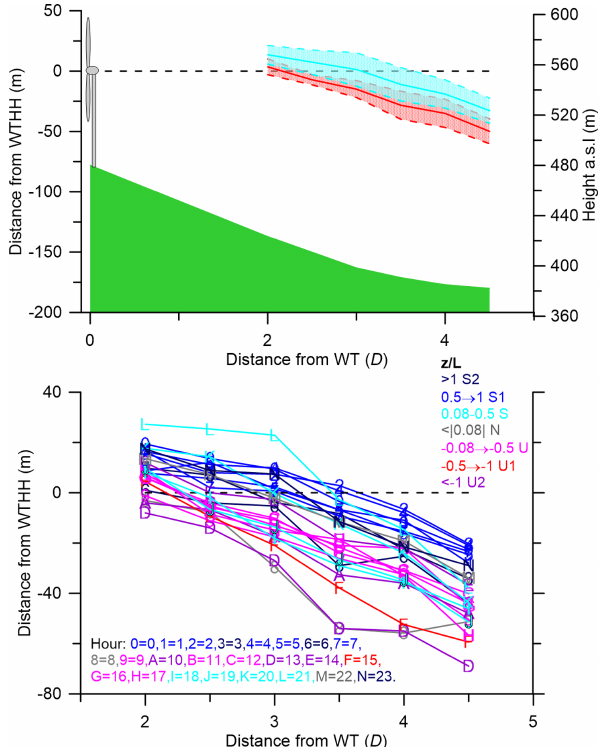
Figure 16. Top: mean vertical location ( ± 1 standard deviation) of the wake centre by hour of the day for different distances down- stream of the wind turbine location (A type only) during hours with unstable conditions (red is median value of z/L < − 0 . 08) and stable conditions (cyan is median z/L >0.08). Bottom: same data as in the upper panel but shown by hour of the day. Wake centre locations are shown for each hour of the day (indicated by the number and letter in the inset box). Red and pink colours indicate hours typified by unstable conditions, blue colours depict hours of the day when stable conditions prevail, and the grey lines depict data from hours where conditions are frequently near neutral. The legend to the hour is given in the bottom left of the figure, where the hour shown by 0 is midnight, 1 is 01:00UTC and so on to N is 23:00UTC. The corresponding stability colour is given in the legend in the top right. The classes are as follows: S 2 where z/L >1 is the most stable (dark blue colour), S 1 where 0.5< z/L <1 is very stable (blue), S where 0.08< z/L <0.5 is stable (cyan), N where z/L < | 0 . 08 | is neutral (grey), U where − 0 . 08> z/L > − 0 . 5 is slightly unstable (pink), U 1 where − 0 . 5> z/L > − 1 is unstable (red) and U 2 where z/L < − 1 is unstable (purple).